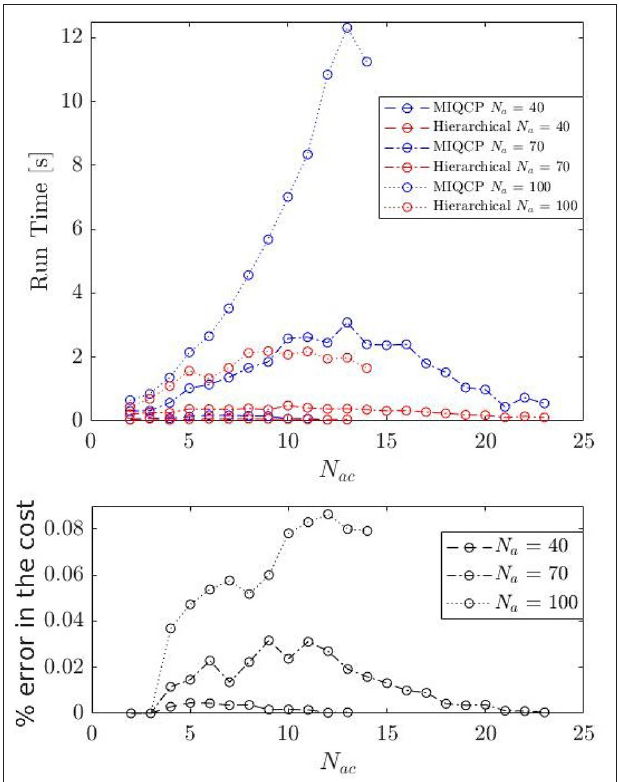
FIGURE 6 | Run-time for assignment algorithms.